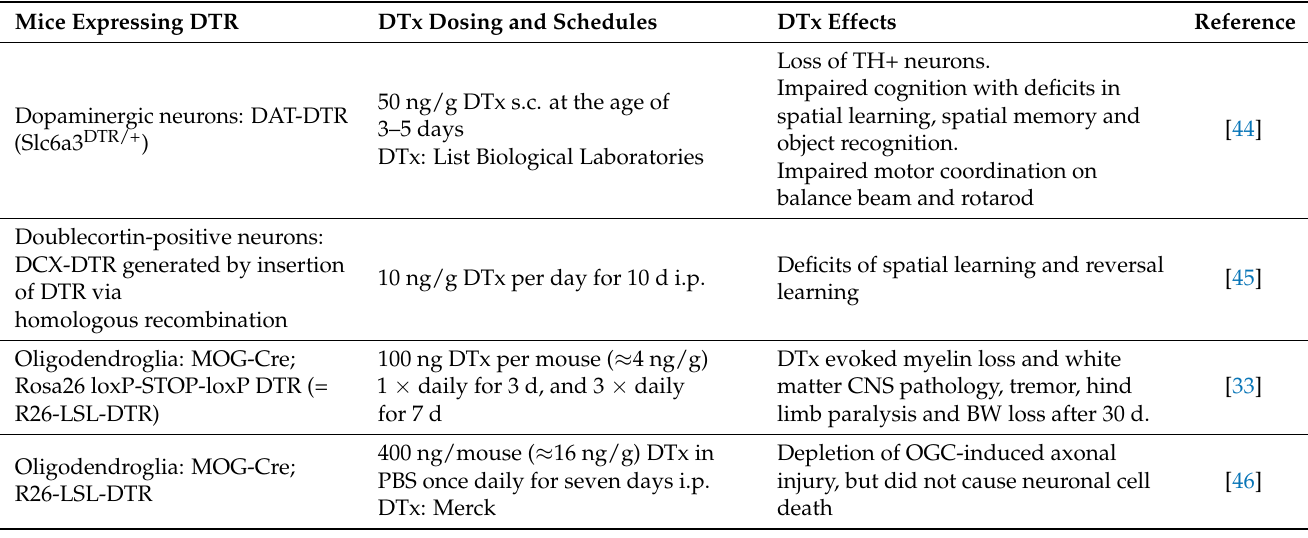
Table 1. Examples of DTx-based mouse models targeting neurons or glia of the central nervous system. Mice Expressing DTR DTx Dosing and